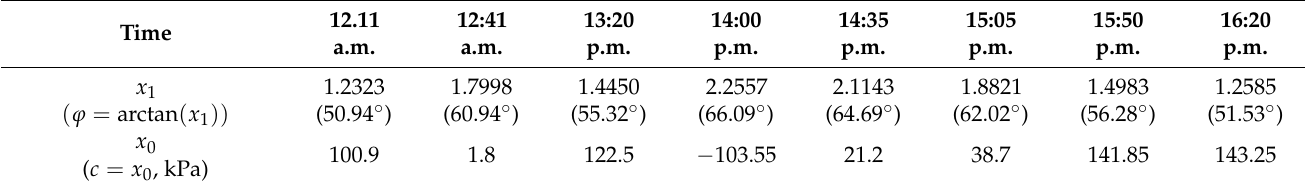
Table 4. The regression coefficients obtained by the traditional regression